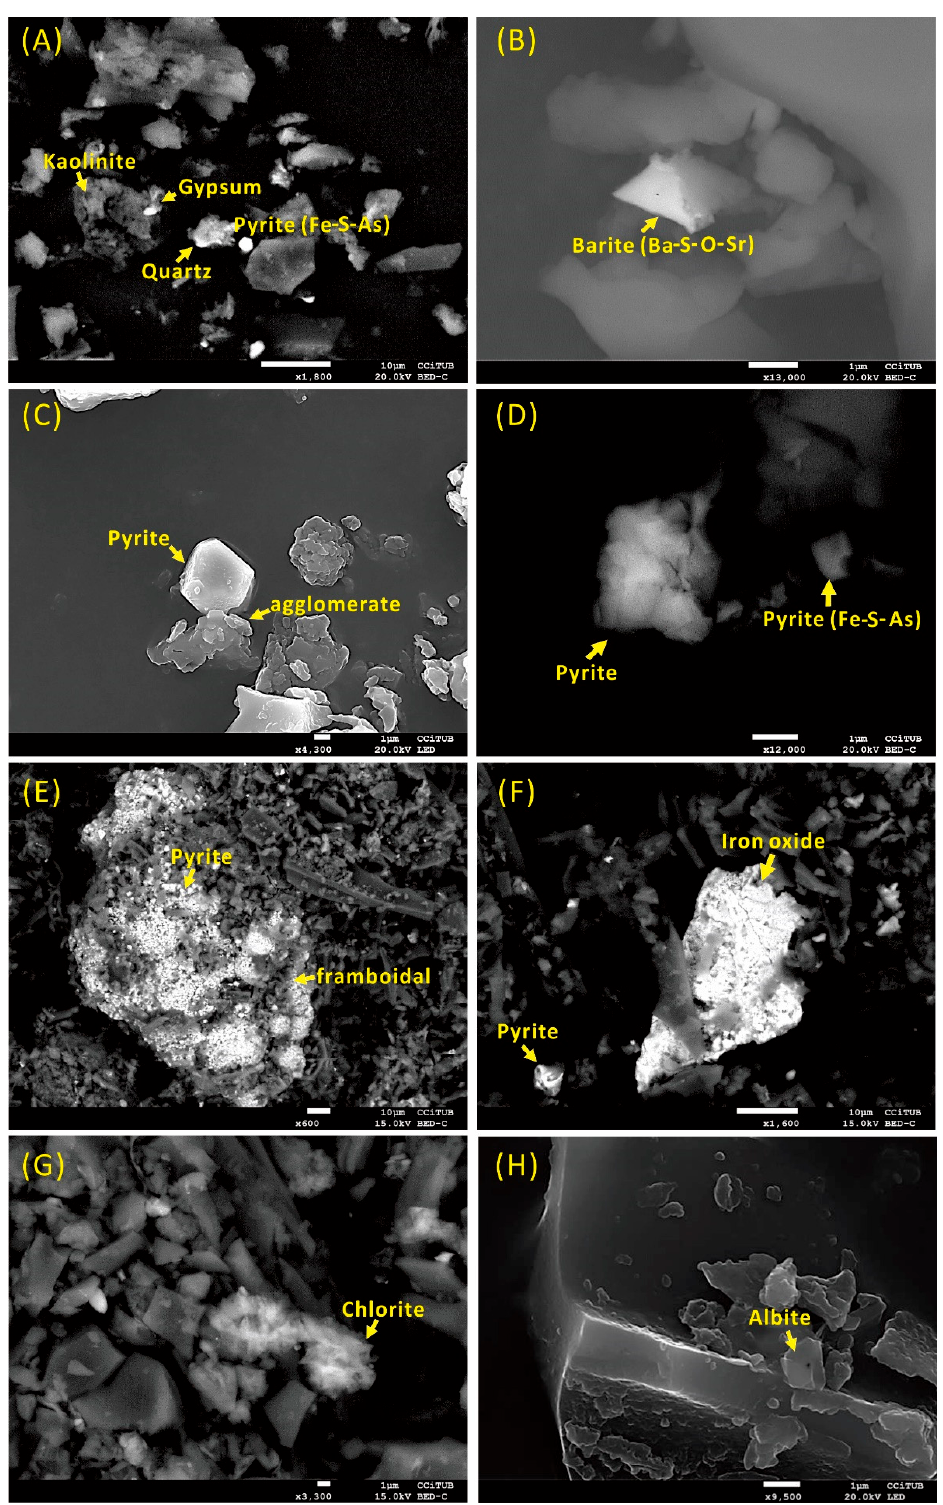
Figure 6. SEM back-scattered electron images of coal samples from WZ profile. ( A ), kaolinite, gypsum, pyrite, and quartz in sample WZ-01. ( B ), Sr-bearing barite in sample WZ-01. ( C ), agglomerate of framboidal pyrite and partially dissolved pyrite in sample WZ-01. ( D ), pyrite and As-bearing pyrite in sample WZ-01. ( E ), framboidal pyrite in sample WZ-03. ( F ), disseminated pyrite and iron oxide in sample WZ-03. ( G ), chlorite in sample WZ-03. ( H ), albite in sample WZ-01.